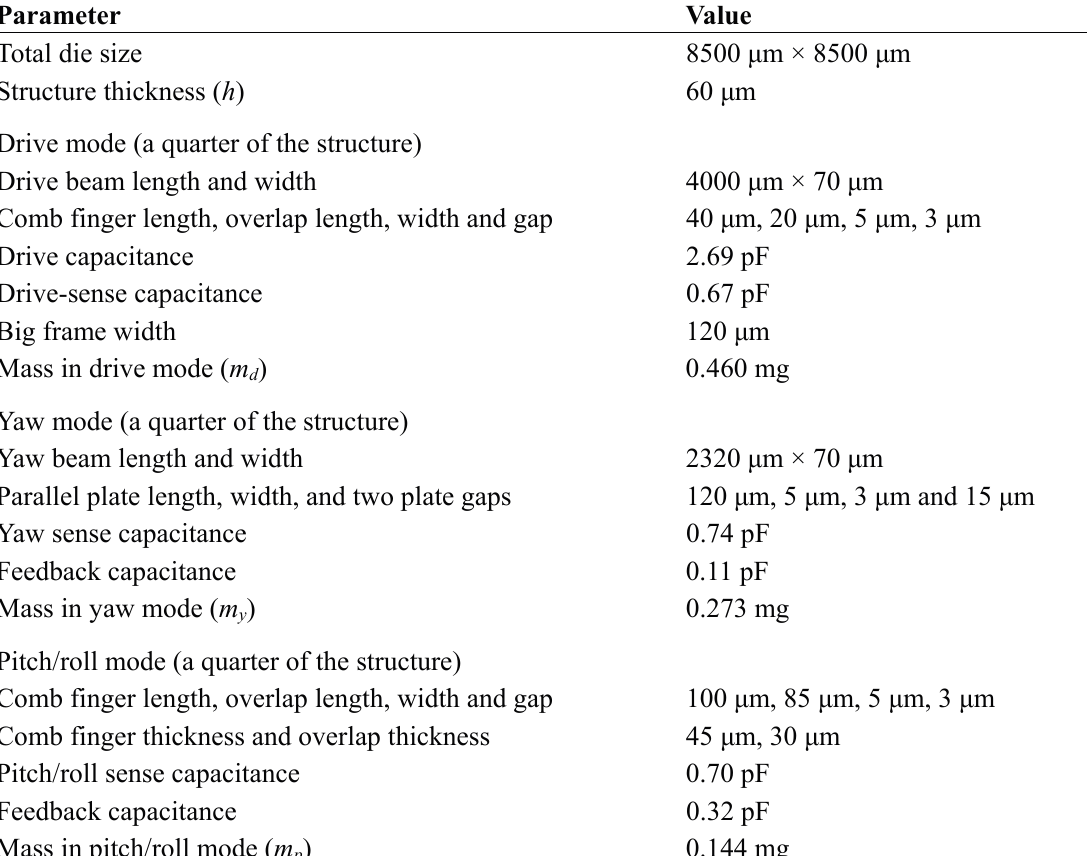
Table 2. Part of the structure